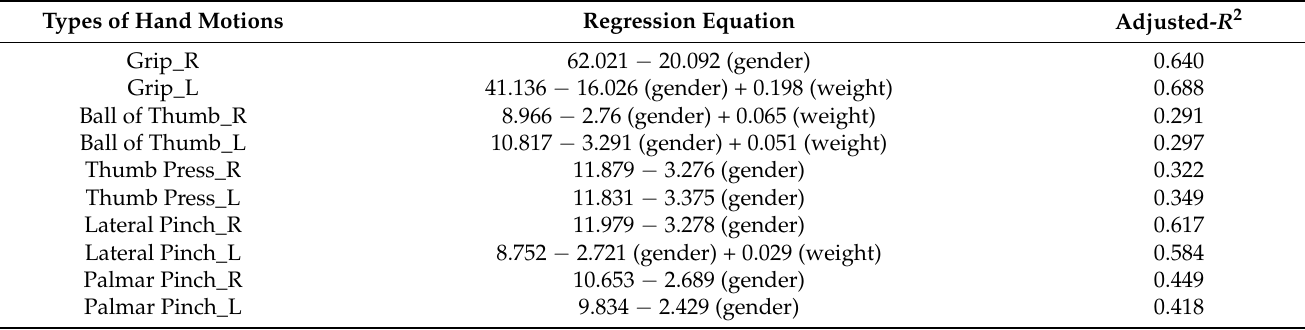
Table 2. The prediction models by demographic information (gender and weight) of different types of hand strength. Types of Hand Motions